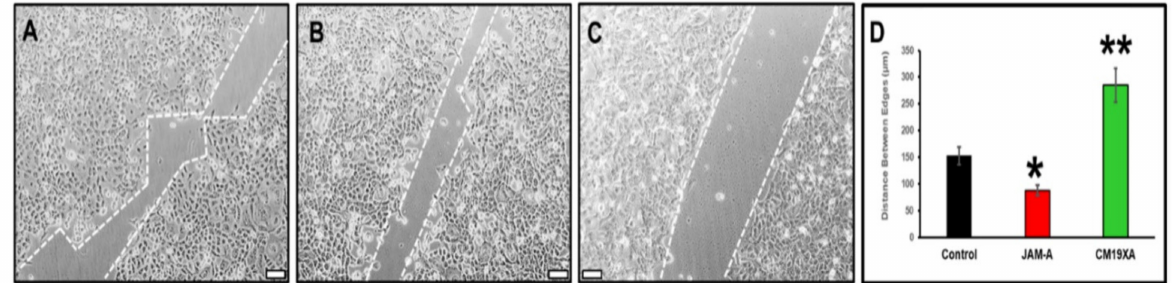
Figure 3. Wound healing assay. The movement of CAL27 cells 24 h after removing the silicon inserts that separate the cells. The gap size at time 0 h is 500 µ m. Culture conditions: ( A ) control, no addition of proteins, ( B ) 1 µ M JAM-A, ( C ) 1 µ M CM19XA. For each condition, at least 900 individual cells were tracked using FastTrack Artificial Intelligence (AI) automated analysis system, an AI-based vision system from MetaVi Labs/Ibidi (cat no. 32200-3; IBIDI, Gräfelfing, Germany). ( D ) Statistical analysis of the movement of CAL27 cells. The graph reports the average distance between edges of CAL27 cells. The data from four independent wound healing assay experiments are shown as the mean ± SD. The statistics show that when comparing control versus JAM-A (*) results in a p < 0.04. When comparing the control versus CM19XA we get (**) a p -value of p < 0.01. These results show that the bigger gap from CM19XA cells is from an increase in TJ formation, which leads to a decrease in cell proliferation and migration. However, with JAM-A there was a decrease of the gap, showing that these cells are proliferating and migrating due to a decrease in TJ formation. These results show that CM19XA decreases the migration from the cancer cells, which is reflective of the decrease in proliferation. Scale bar in panels ( A – C ) represents 100 µ